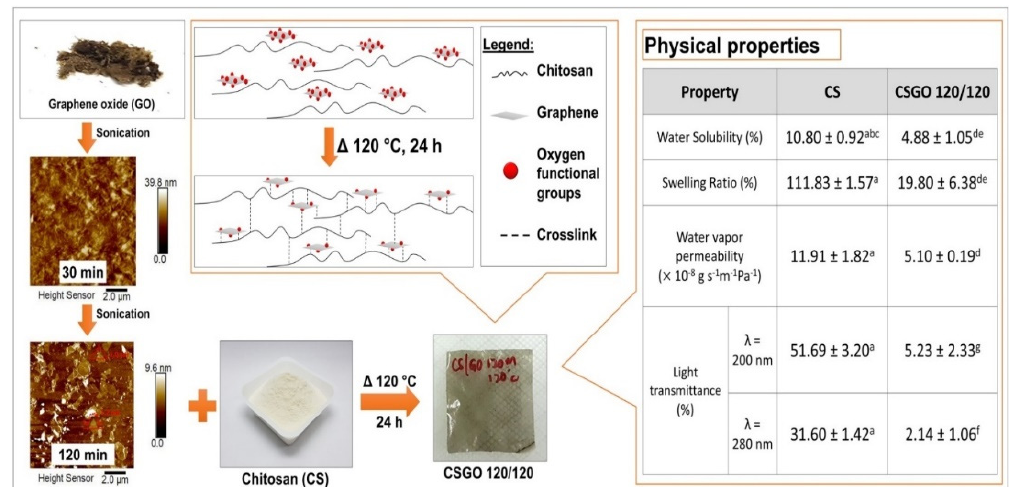
Figure 5. Fabrication of chitosan/GO nanocomposite via ultrasonication which controlled the size and thickness of GO nanosheets. The nanocomposite thin film showed a remarkable decline in UV transmittance, a temperature of 120 °C and compacted hydrophilic properties [116].